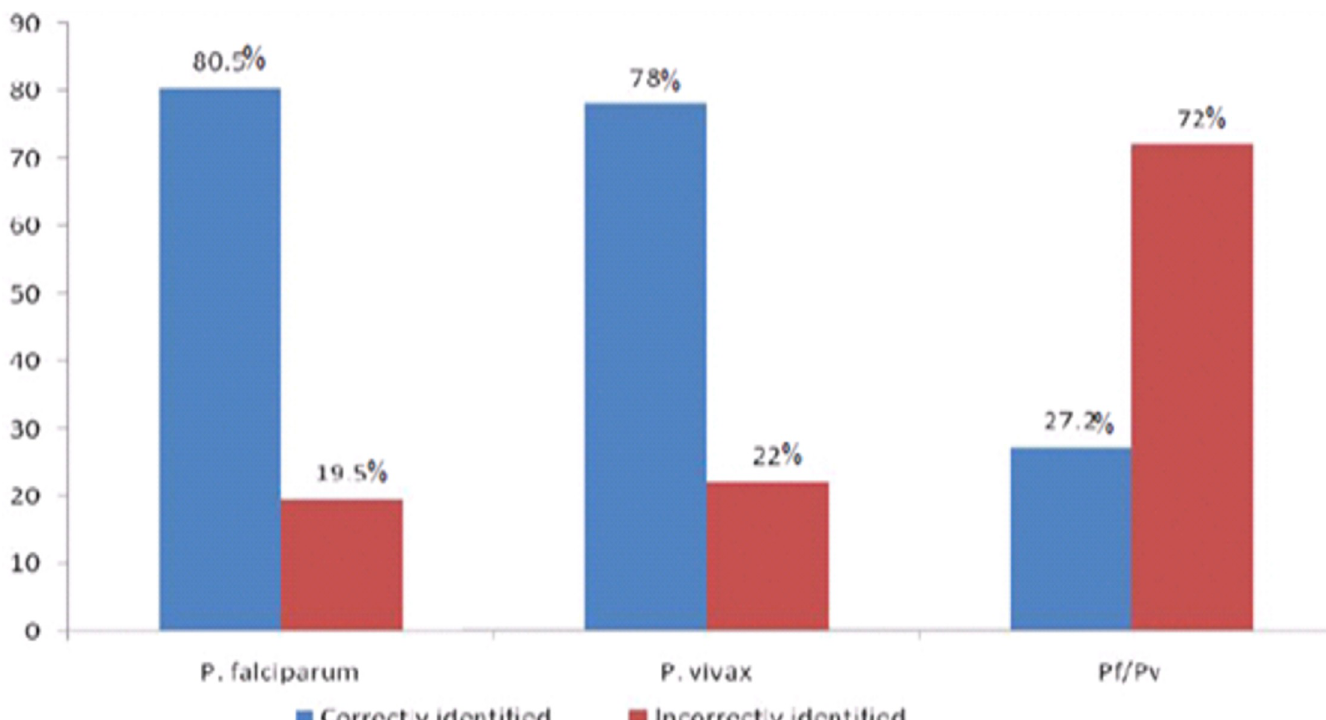
Fig 2. Performance of laboratory professionals on identification of Plasmodium species at health institutions in Bahir Dar city administration from January to March, 2017.